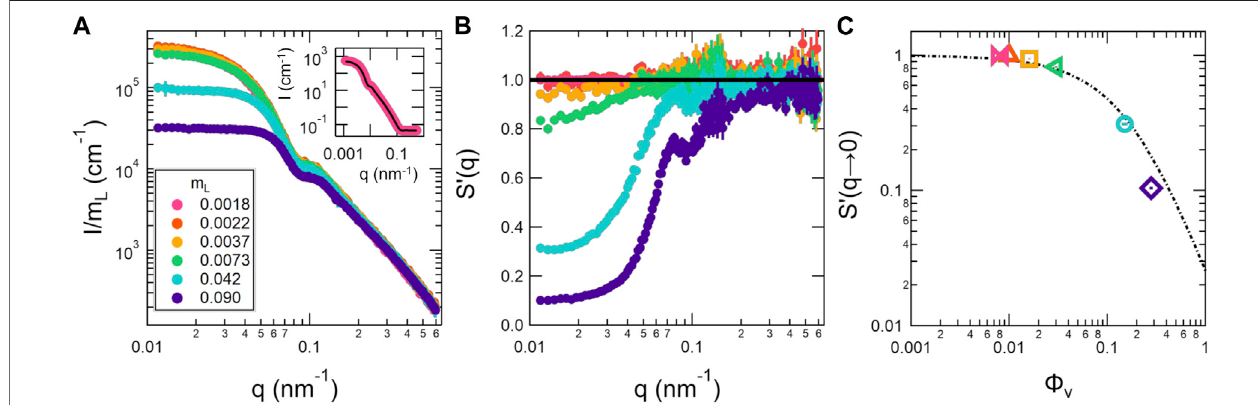
FIGURE 1 | Normalized SANS data (A) , corresponding apparent structure factors S ′ ( q ) (B) , and extrapolated S ′ ( q → 0) (C) for a concentration series of SOPC unilamellar vesicles. The SANS data in (A) were normalized by the corresponding lipid mass fraction, m L . The insetshows the measured intensity over the entire q range for the lowest lipid volume fraction, m L = 0.0018, which corresponds to ϕ V = 0.0076, (points) and fi ts to avesicle form factor (solid line). The apparent structure factors in (B) werecalculatedbydividingoutthemeasuredintensityforthe m L =0.0018samplefollowing Eq.4 .The S ′ ( q → 0)weredeterminedbyextrapolatingtheapparent structurefactors in (B) to q =0 nm − 1 (points) and areplottedversusthevesicle volume fraction ( ϕ V ) calculatedbased onthe R H value listed in Table2 . The dotted linein (C) corresponds to analytic expression for S (0) in monodisperse hard sphere systems [51]; [52]. Error bars represent one standard deviation and in some cases are smaller than the symbols.